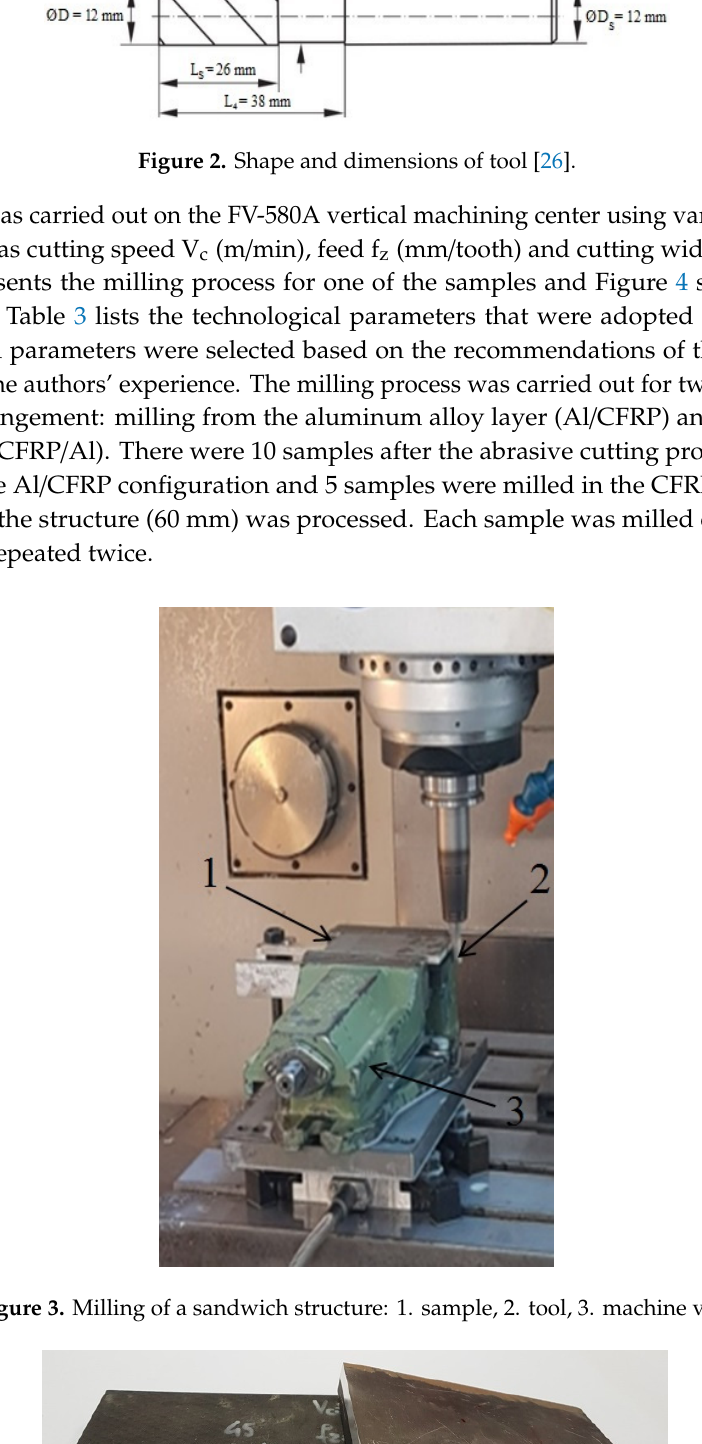
Figure 4. Samples after milling.